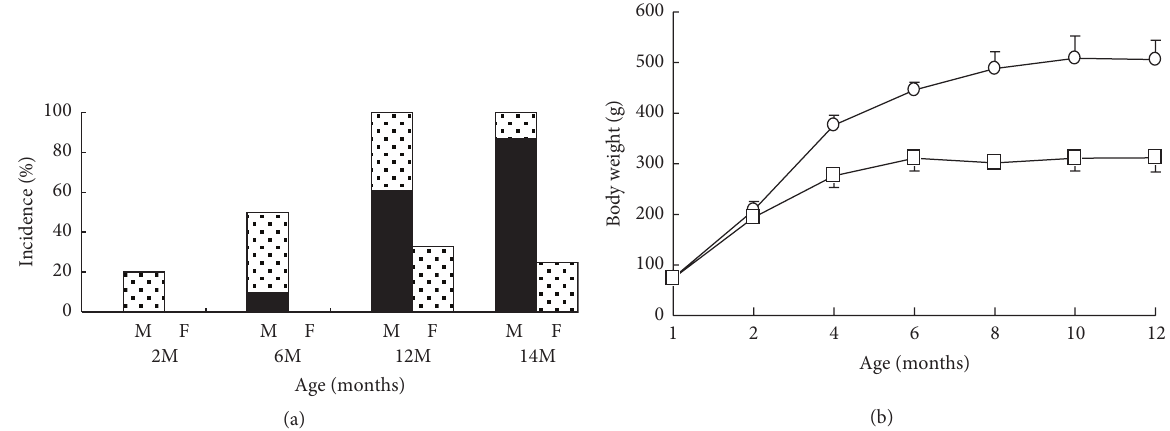
Figure 1: (a) Incidence of diabetes mellitus in LEA rats as determined by OGTT. Dotted and closed bars indicate IGT and DM, respectively. M and F indicate male and female, respectively. 𝑛 = 32 for males at each age; 𝑛 = 26 for females at each age. (b) Changes of body weight in male (open circle, 𝑛 = 5 ) and female (open square, 𝑛 = 5 ) LEA